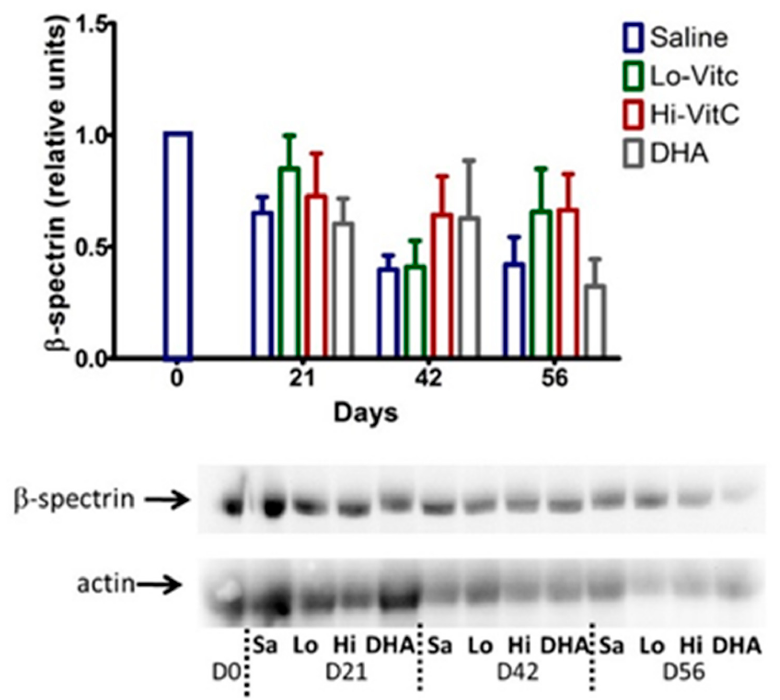
Figure 7. Expression of β -spectrin in stored RBC. The β -spectrin content of RBC stored in saline progressively declined over 56 days. Addition of reduced VitC (Lo/Hi) or oxidized VitC (DHA) increased β -spectrin levels of RBC over saline (Sa). However, these changes did not reach statistical significance. ( N = 5/group, p > 0.05).).